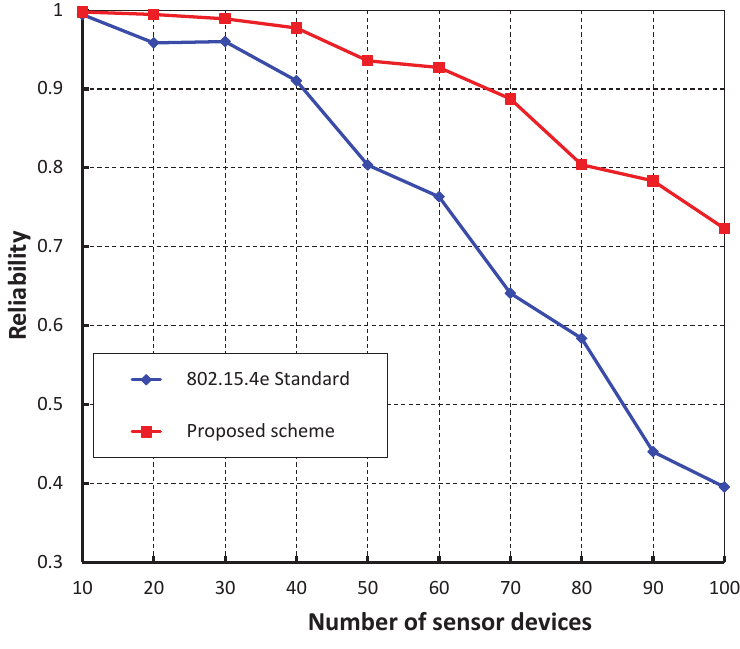
Figure 11. Comparison of reliability of our proposed scheme with the IEEE 802.15.4e standard.